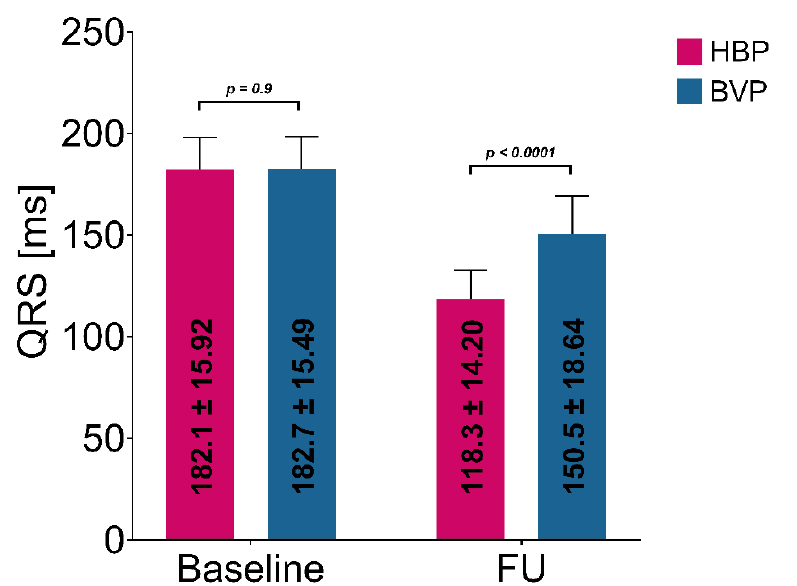
Figure 1. QRS duration at baseline (right ventricular paced) and follow-up (FU). HBP–His bundle pacing, BVP–biventricular pacing, QRS—QRS wave complex.